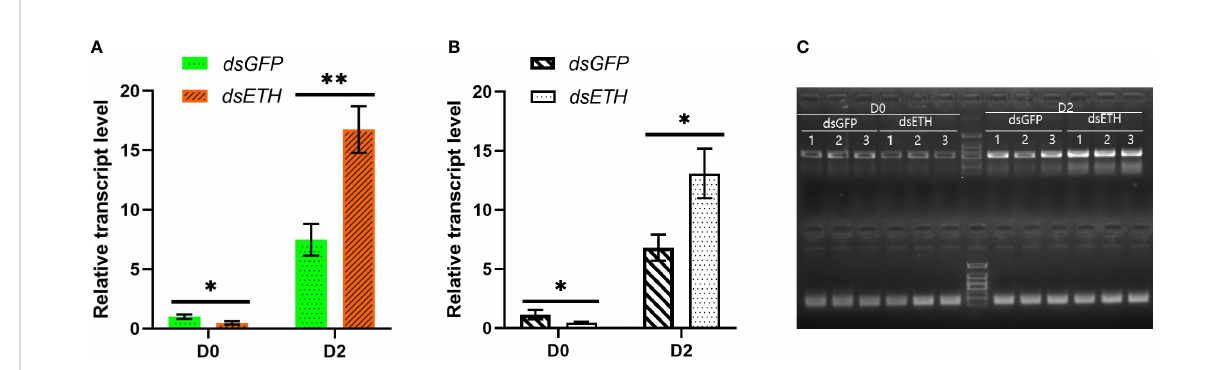
FIGURE 1 Relative transcript levels of ETH in thoracic ganglia of dsGFP- and dsETH -injected crabs at the D0 and D2 substages were measured respectively [by Student ’ s t-test, values are means ± SD (n = 3), * P < 0.05; ** P < 0.01]. (A) RT-qPCR result; (B) RT-PCR result; (C) Images of the gels for